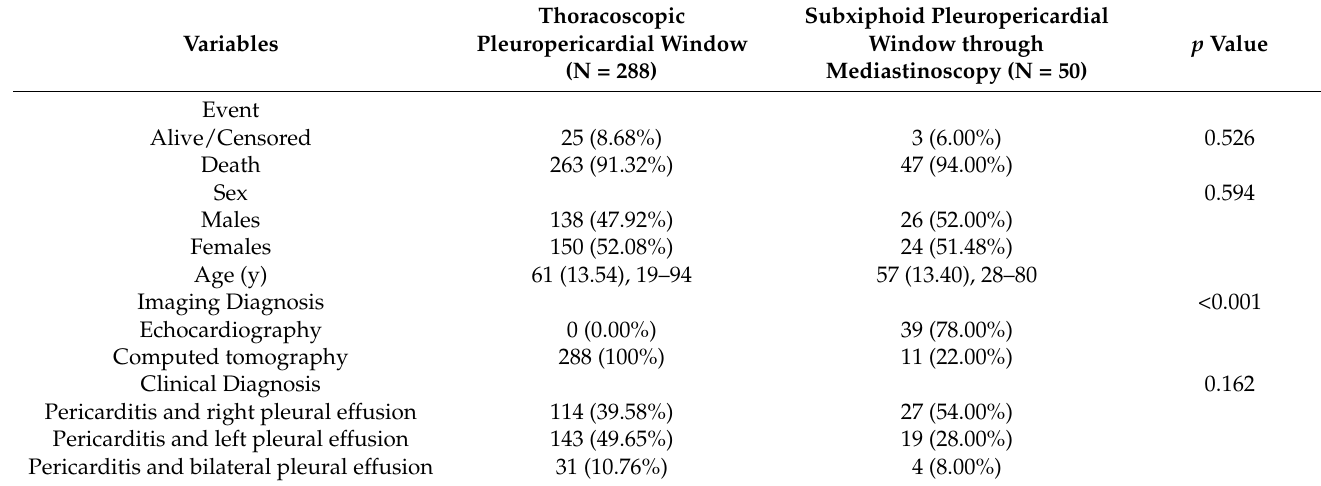
Table 1. The clinical characteristics of patients and diagnosis type by surgery